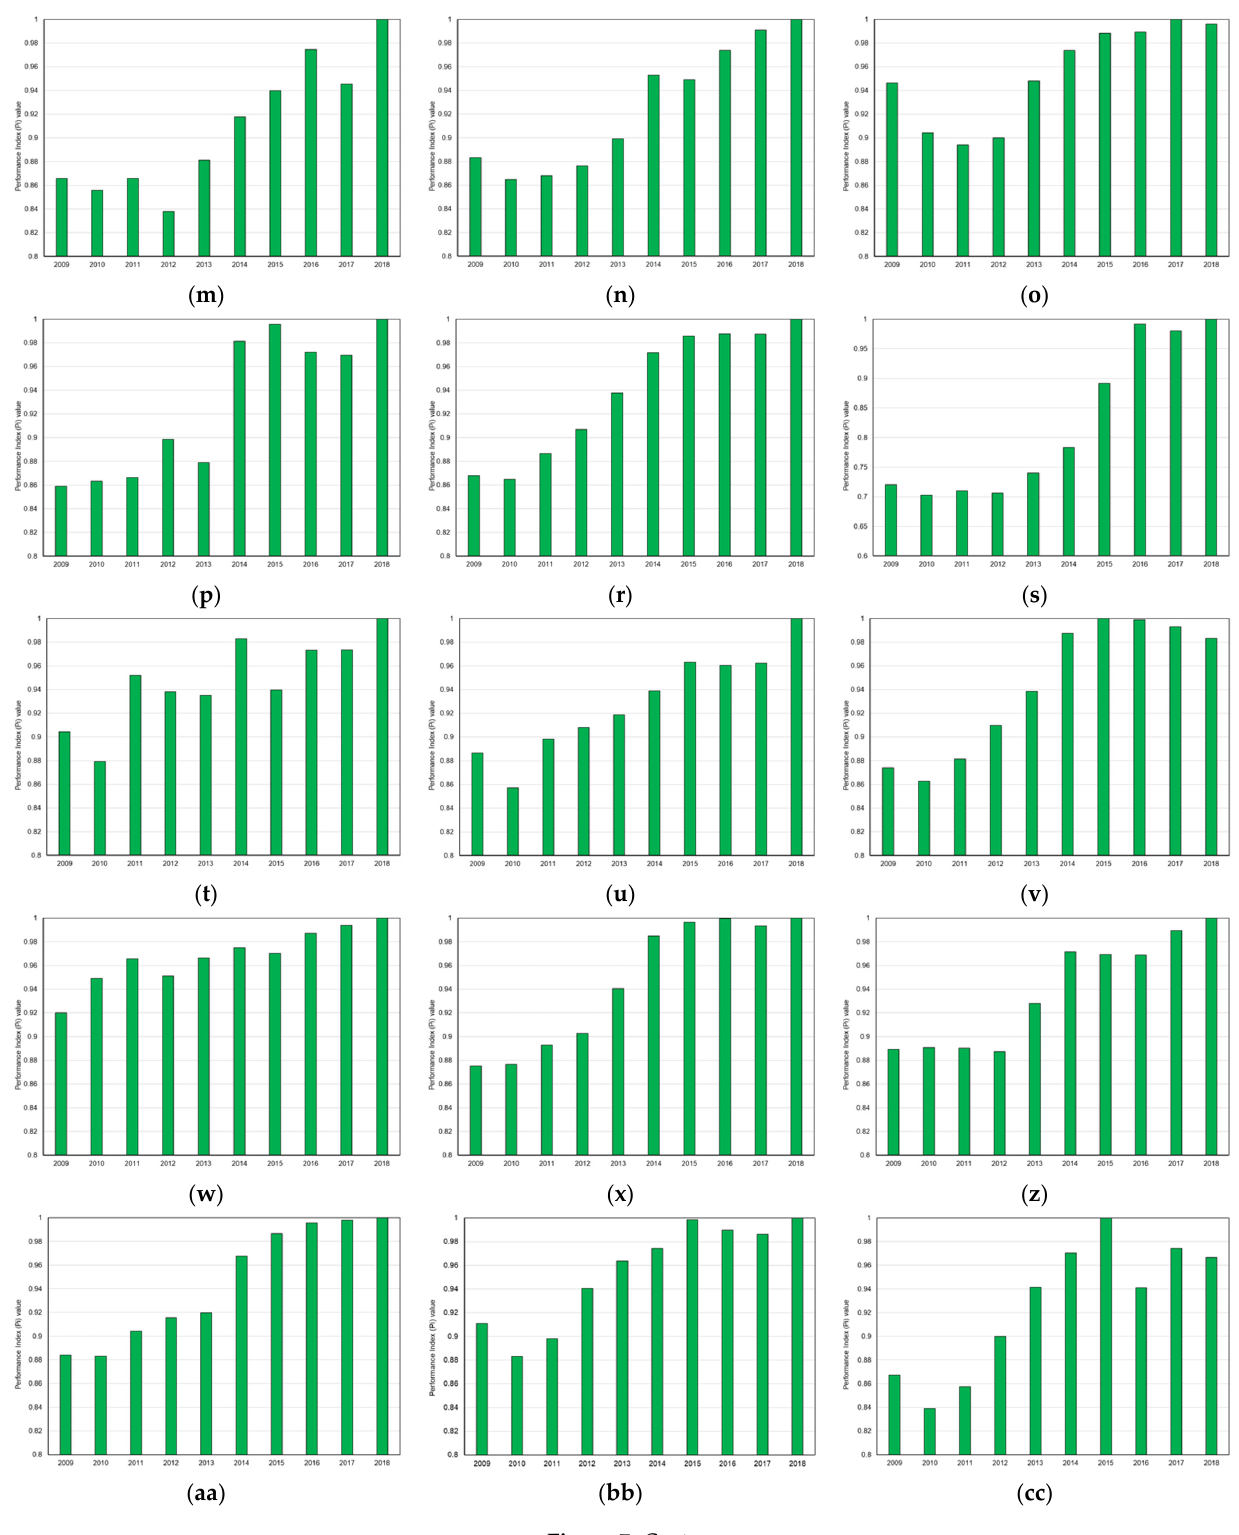
Figure 7. The value of the P i index of energy and climate sustainability in each EU country in the studied years ( a —Belgium, b — Figure 7.